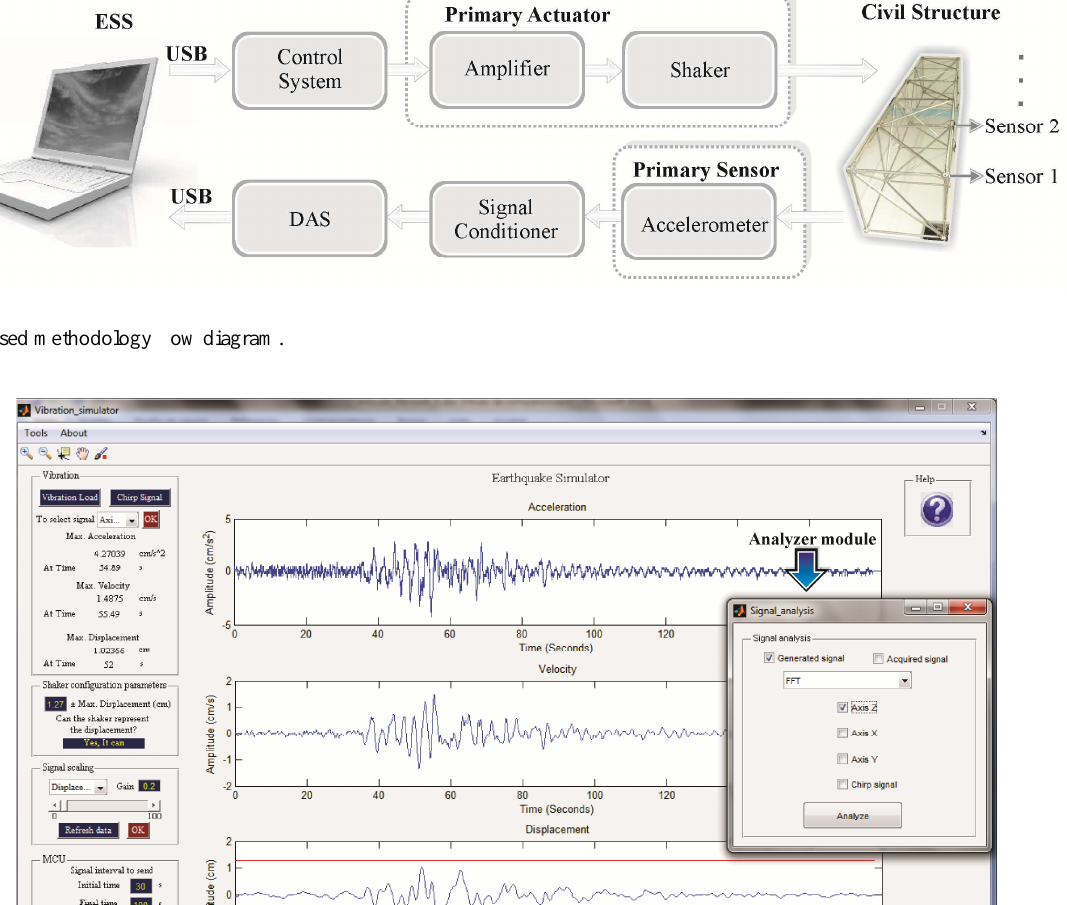
Figure 3. ESS unit. 3